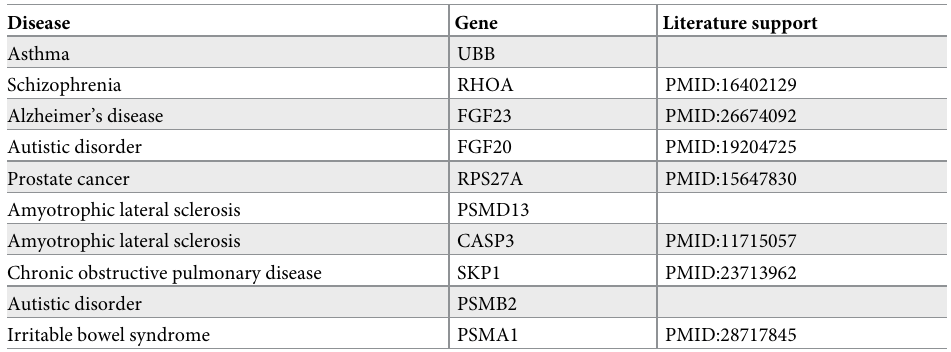
Table 3. Top 10 disease–gene predicted by GPD.